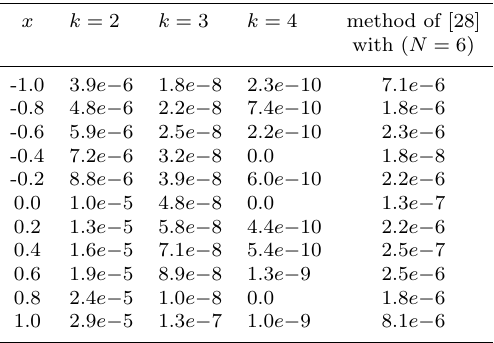
Table 4. Absolute error of Example